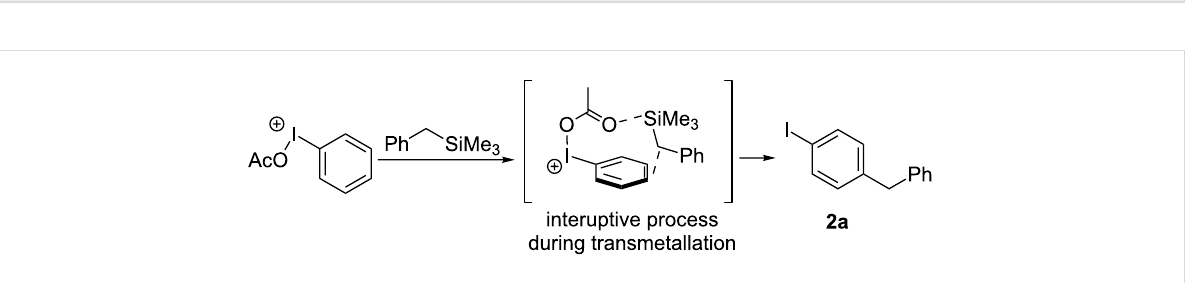
Scheme 2: Crossover reaction experiments.